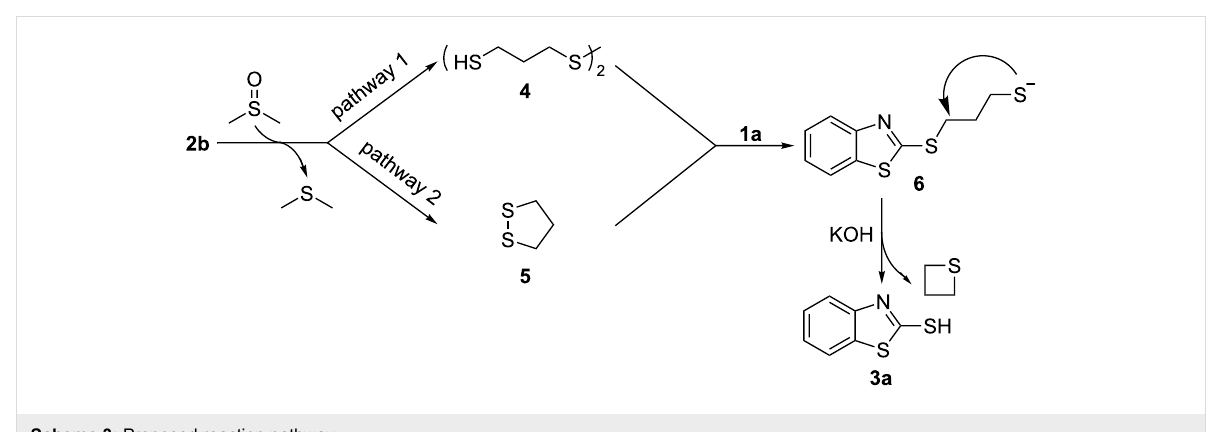
Scheme 3: Proposed reaction pathway.